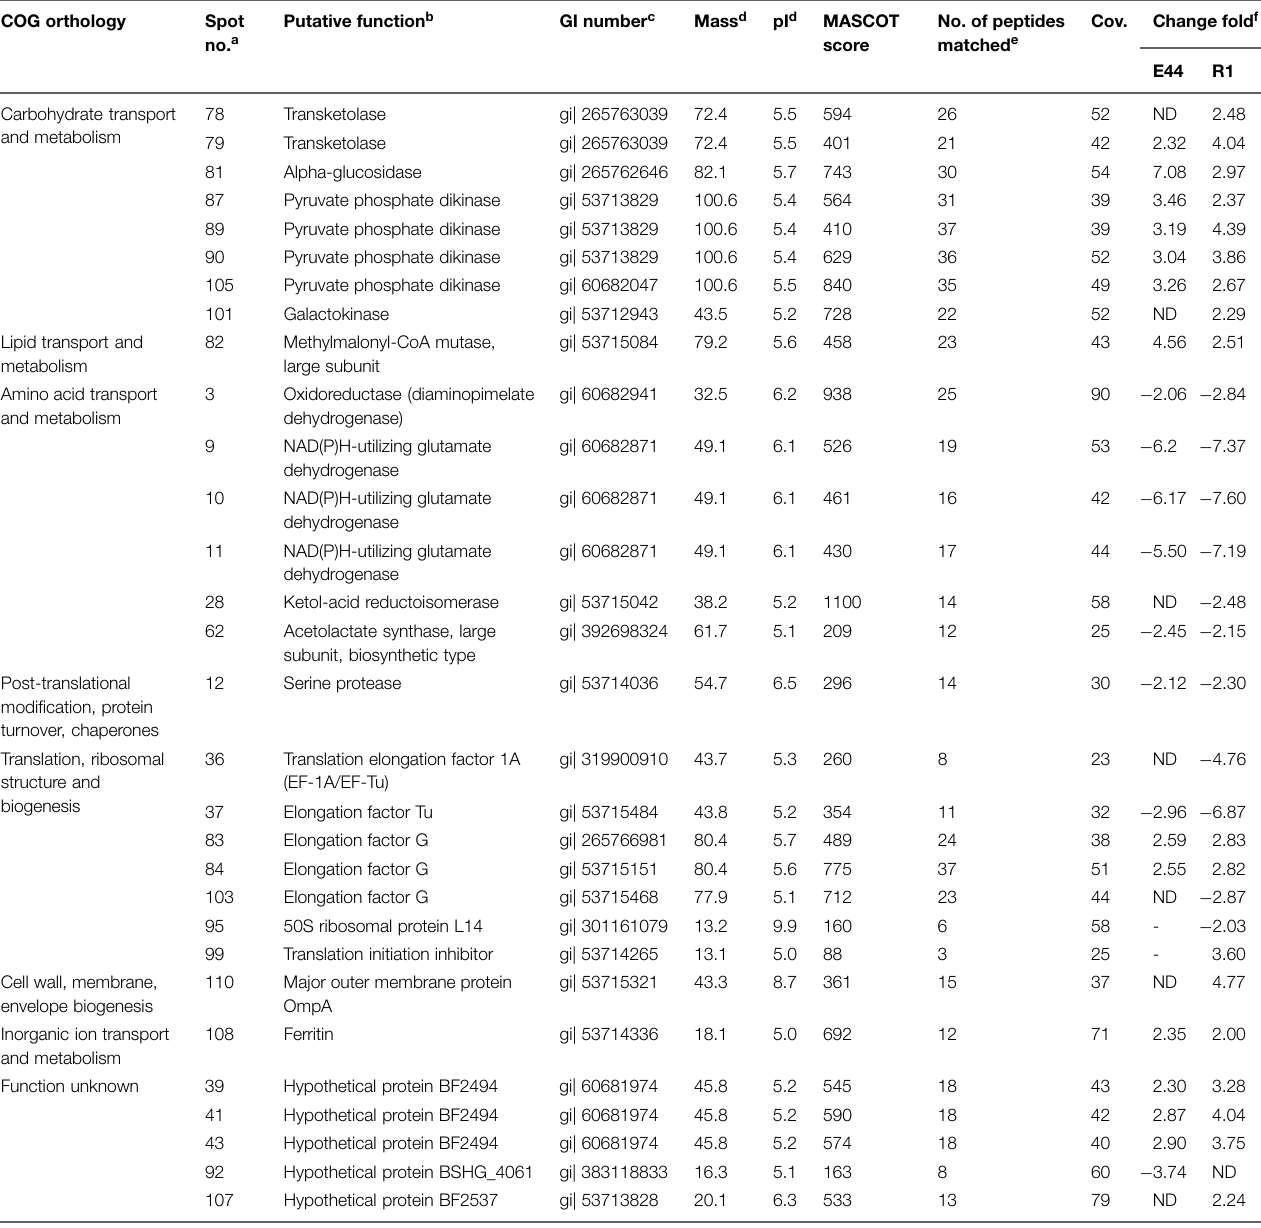
TABLE 2 | Identification of B. fragilis DSMZ 2151 proteins affected by carbohydrate sources. COG